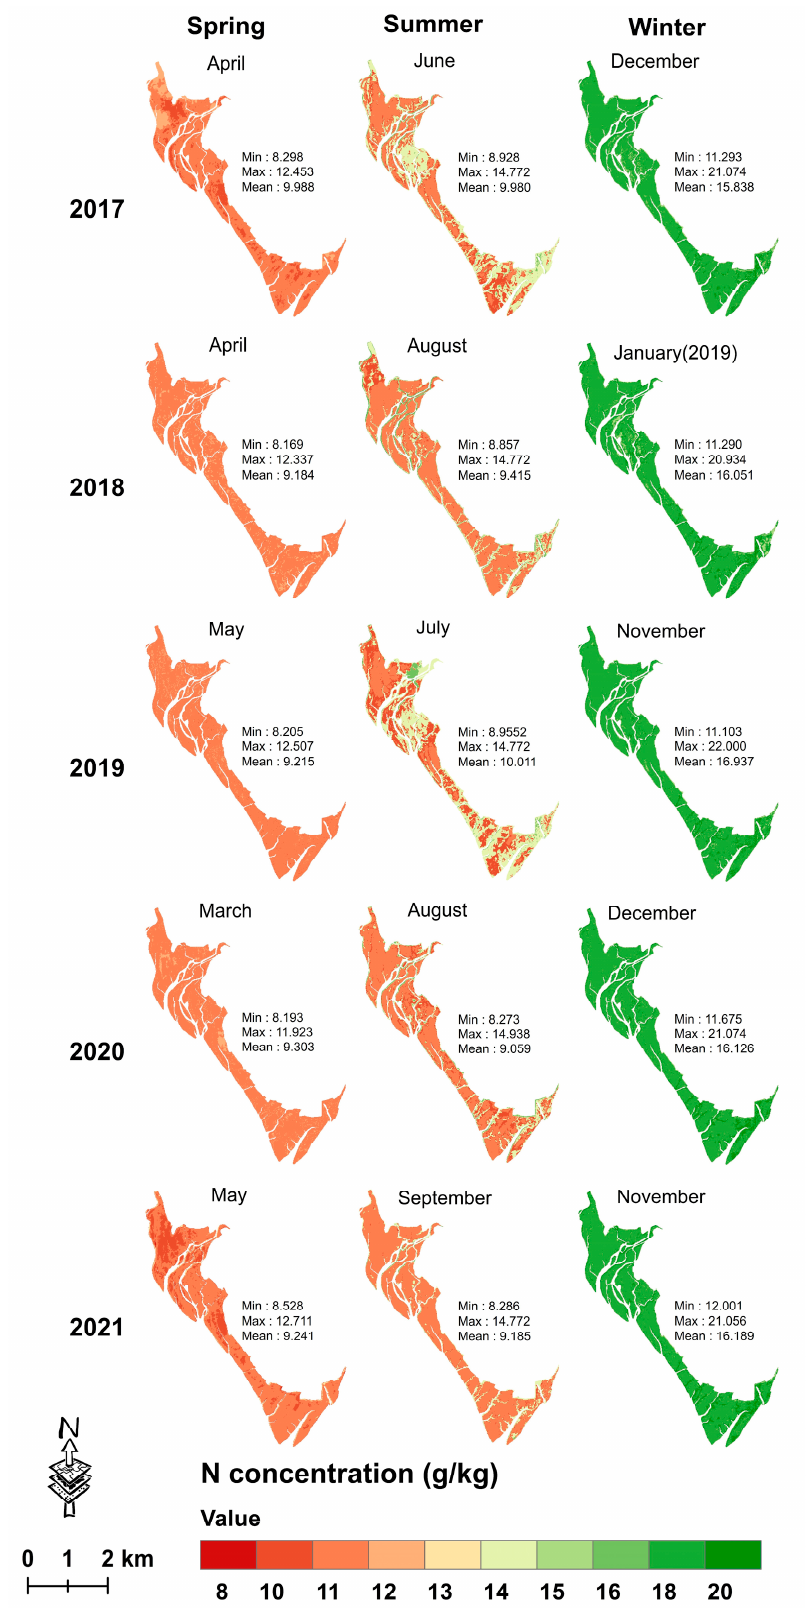
Figure 8. Seasonal leaf C mapping from 2017 to 2021 using the XGBoost model with the dataset of a single season.